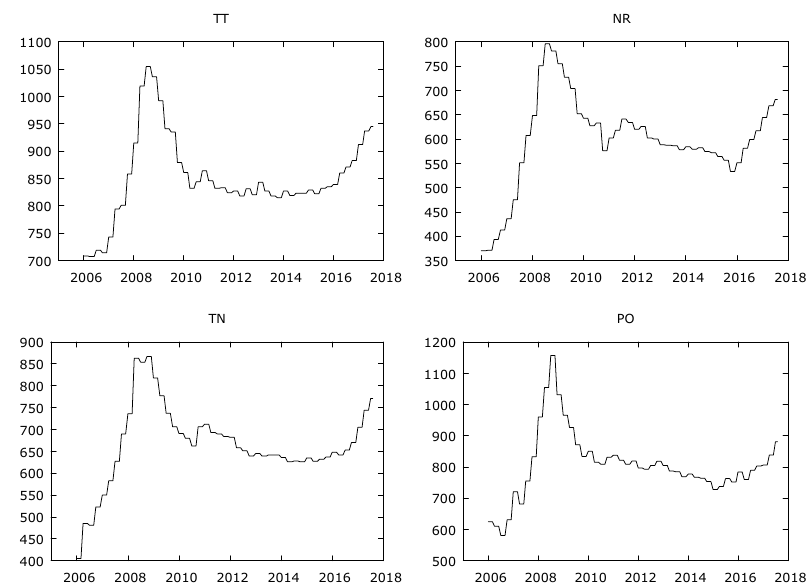
Figure 7. Residential real estate prices in the regions with lower prices—Trnava, Nitra, Trencin and Presov in 2005–2018. Source: Reproduced from National Bank of Slovakia 2018. TT = residential real estate prices in the Trnava region; NR = residential real estate prices in the Nitra region; TN = residential real estate prices in the Trencin region; PO = residential real estate prices in the Presov region.